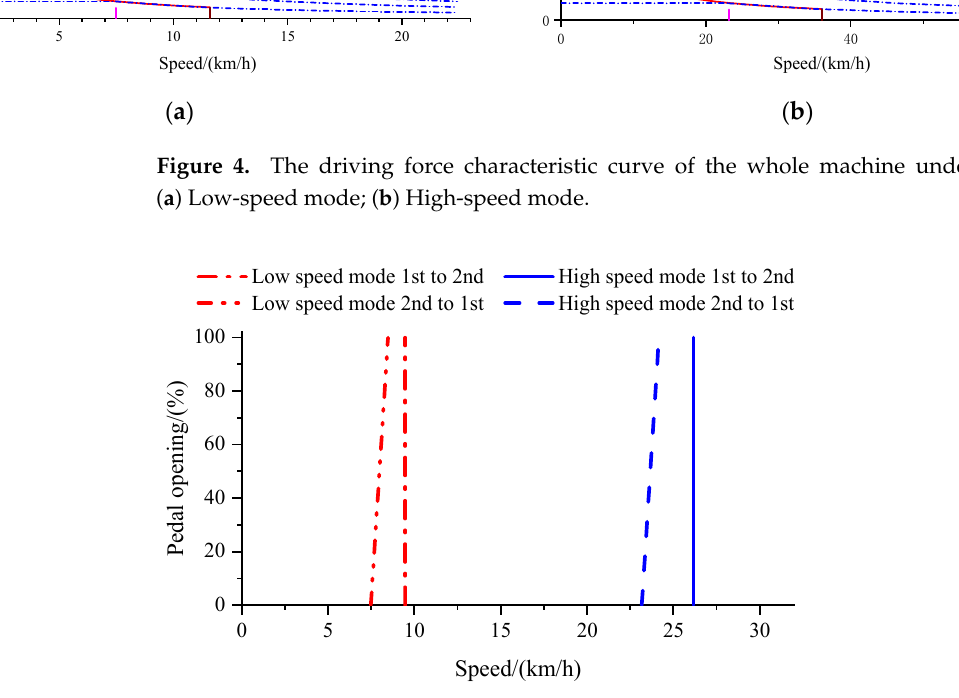
Figure 5. The optimal power shift rule curve.